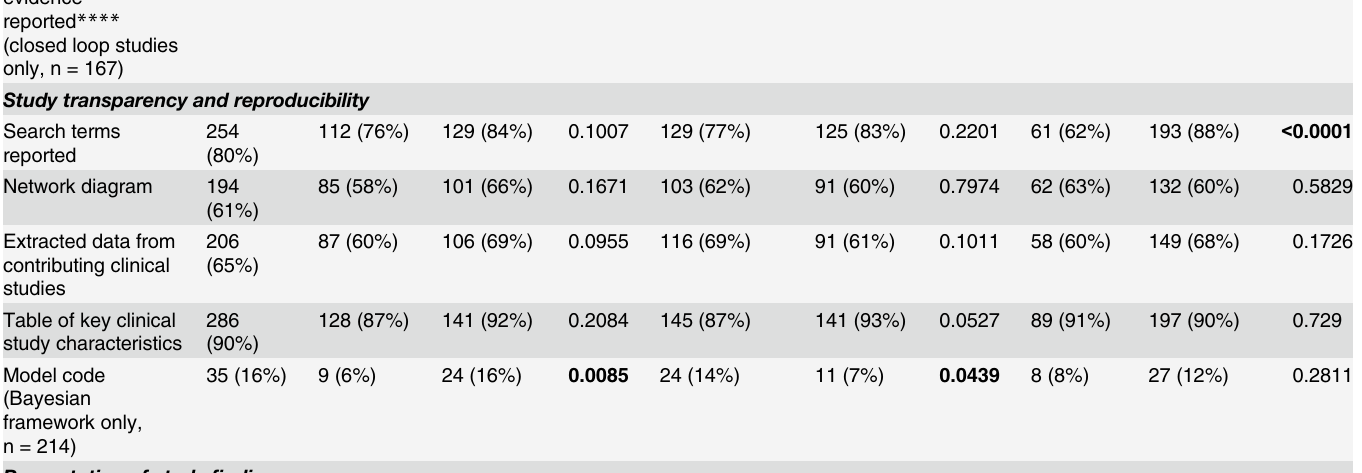
Table of key clinical study characteristics